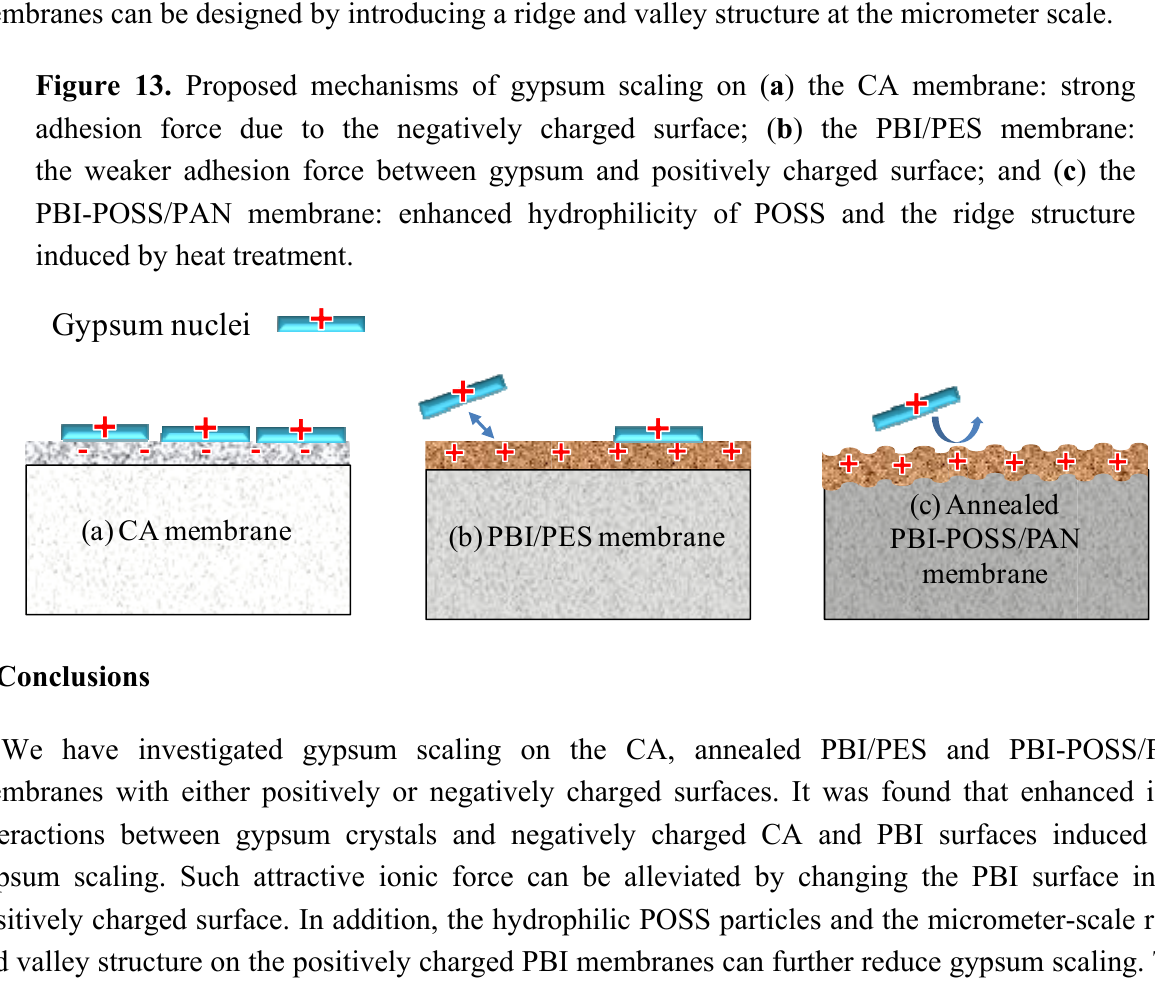
Figure 13. Proposed mechanisms of gypsum scaling on ( a ) the CA membrane: strong adhesion force due to the negatively charged surface; ( b ) the PBI/PES membrane: the weaker adhesion force between gypsum and positively charged surface; and ( c ) the PBI-POSS/PAN membrane: enhanced hydrophilicity of POSS and the ridge structure induced by heat treatment.